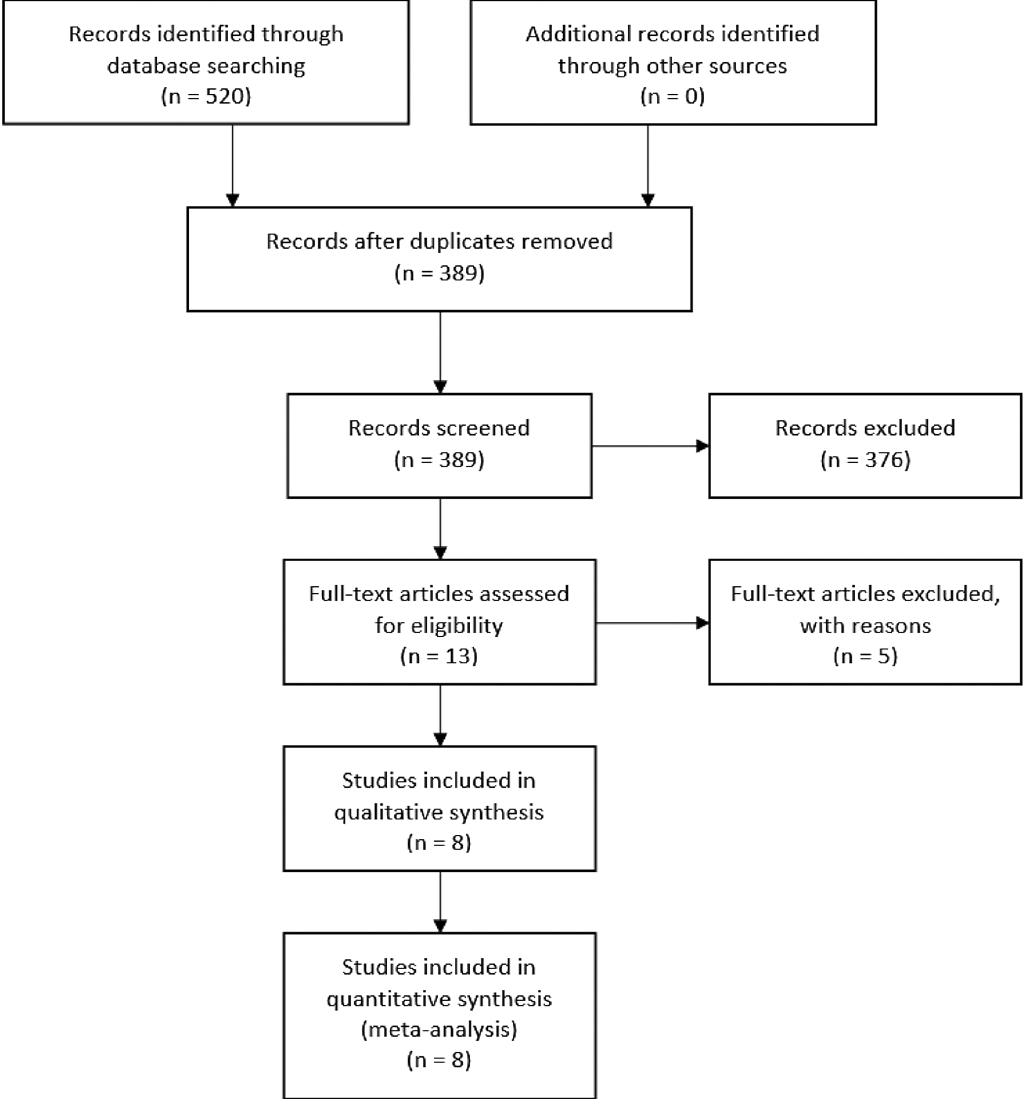
Figure 1. PRISMA flowchart detailing the article identification, screening, and inclusion process and results. Initial database searching yielded 520 items, 389 of which were left after duplicate screening. Abstract screening excluded 376 more items. Eight items survived full-text assessment and were included in both the qualitative and quantitative